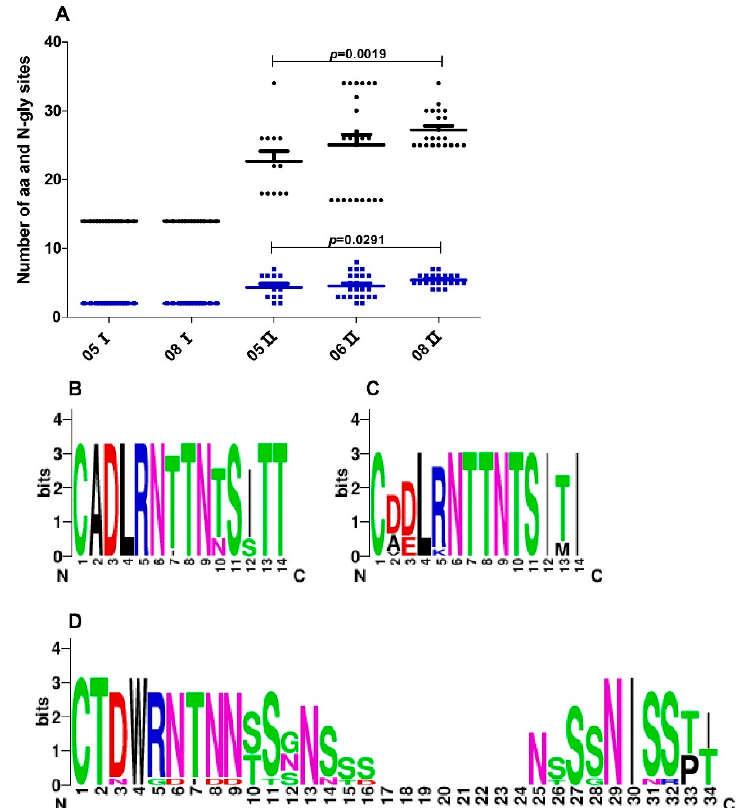
Figure 3. Comparison of sequence length and potential N-linked glycosylation sites (PNGSs) number of the V1 loop. ( A ) Longitudinal analysis of changes in the sequence length and the PNGSs number of Cluster I and Cluster II viruses. Each dot represents one virus variant. Black dots represent V1 loop length. Blue dots represent the V1 loop PNGSs number. The horizontal bars indicate average values per time point, and p -values were calculated using a nonparametric t-test for independent samples. ( B ) Sequence logo of V1 of 2005 Cluster I viruses, which depicts the amino acid conservation pattern across a multiple sequence alignment. The height of each letter indicates the degree of conservation of the most common amino acid at that position. ( C ) Sequence logo of V1 of 2008 Cluster I viruses. ( D ) Sequence logo of V1 of 2005 Cluster II